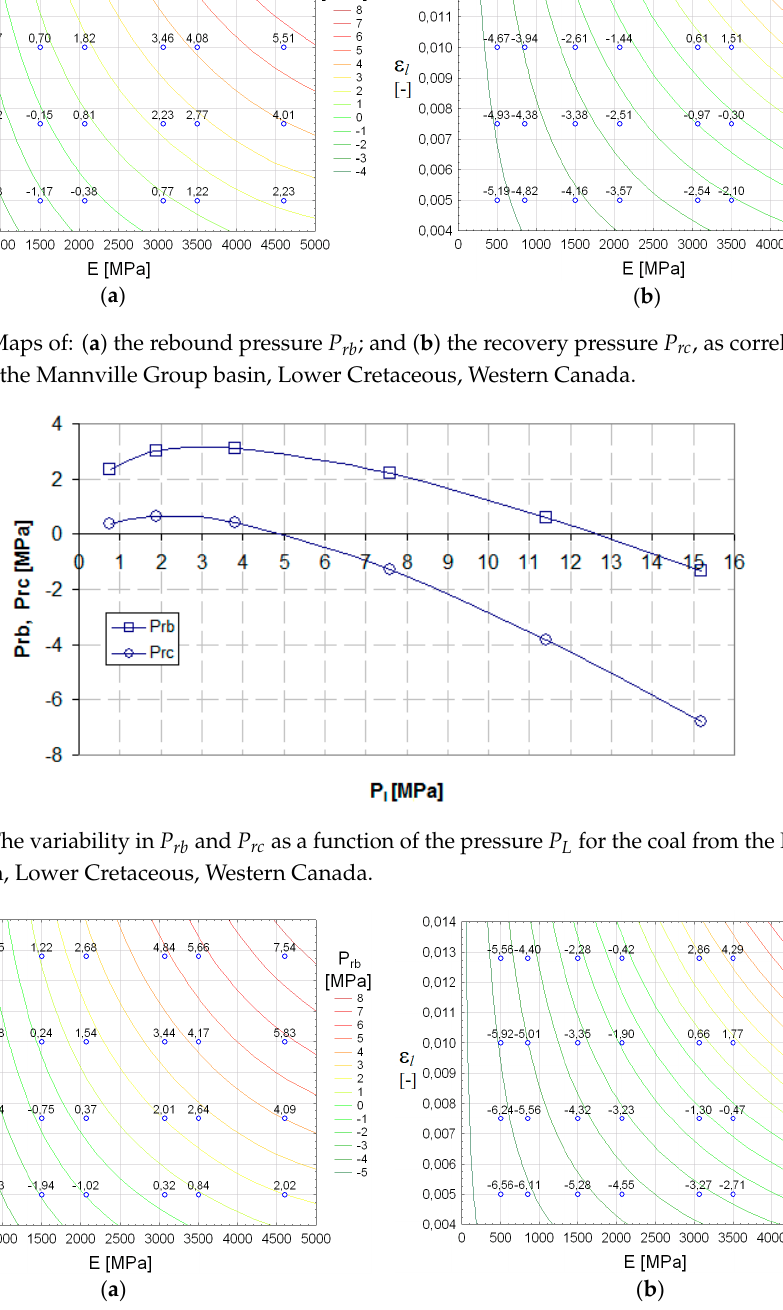
Figure 17. Maps of: ( a ) the rebound pressure P rb ; and ( b) the recovery pressure P rc , as correlated with E and ε l for the Mesaverde Group, Piceance basin, Western Canada. 428